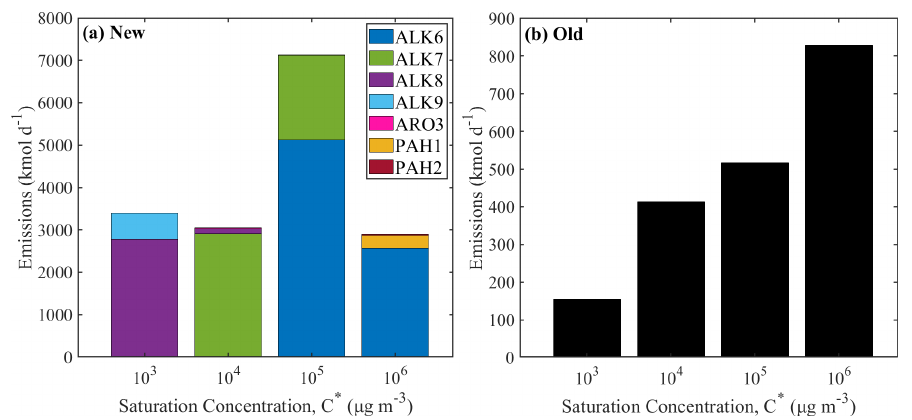
Figure 5. The volatility distribution of the IVOCs emissions from on-road diesel vehicles (a) using the new lumped species approach and (b) using the old VBS approach. Different axes are used for the two